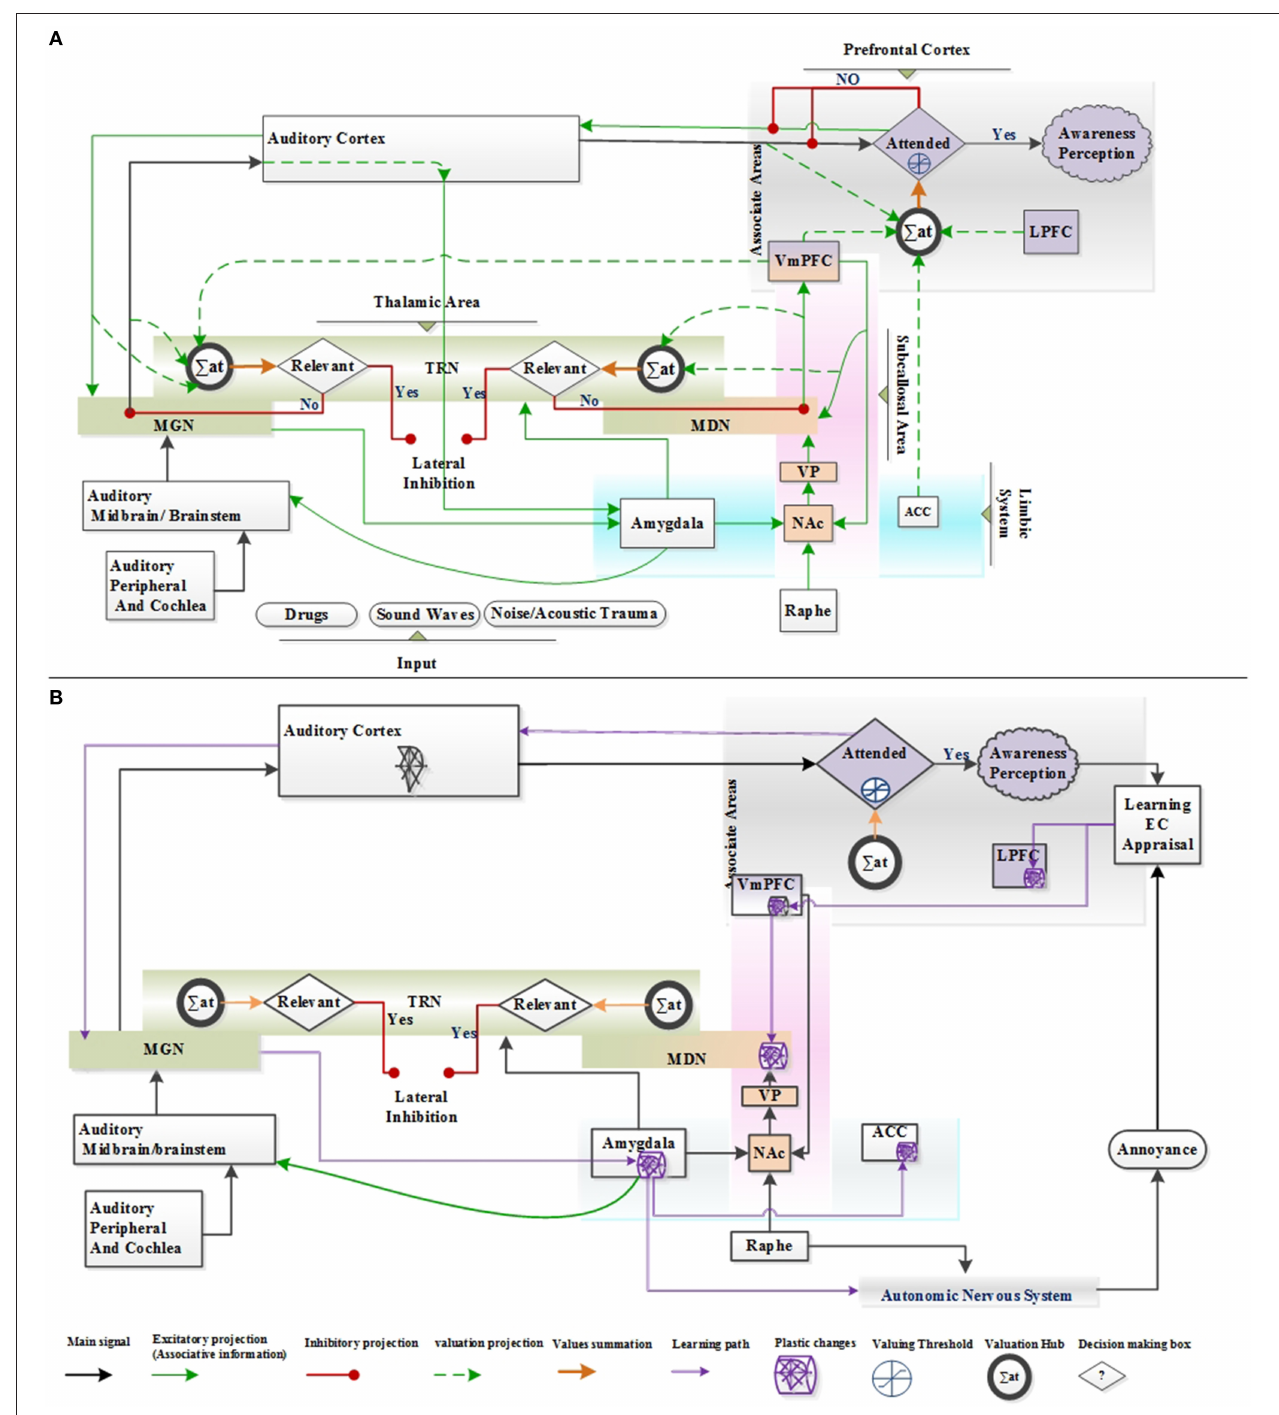
FIGURE 4 | Anatomical structure of the proposed Neurofunctional Tinnitus Model; LPFC, Lateral prefrontal cortex; vmPFC, ventromedial prefrontal cortex; NAc, nucleus accumbens; ACC, anterior cingulate cortex; MGN, medial geniculate nucleus; TRN, thalamic reticular nucleus; VP, ventral palladium; MDN, medial dorsal nucleus; Basal ganglia include VP and NAc; EC, Evaluation Conditioning. (A) Phantom sound perception without negative reaction is defined as “Neutral stage” within the Neurofunctional Tinnitus Model; (B) The evaluation conditioning and appraisal learning procedure and anatomical part of plastic change in tinnitus brain network, is identified as “Clinical Distress stage” of the Neurofunctional Tinnitus Model.